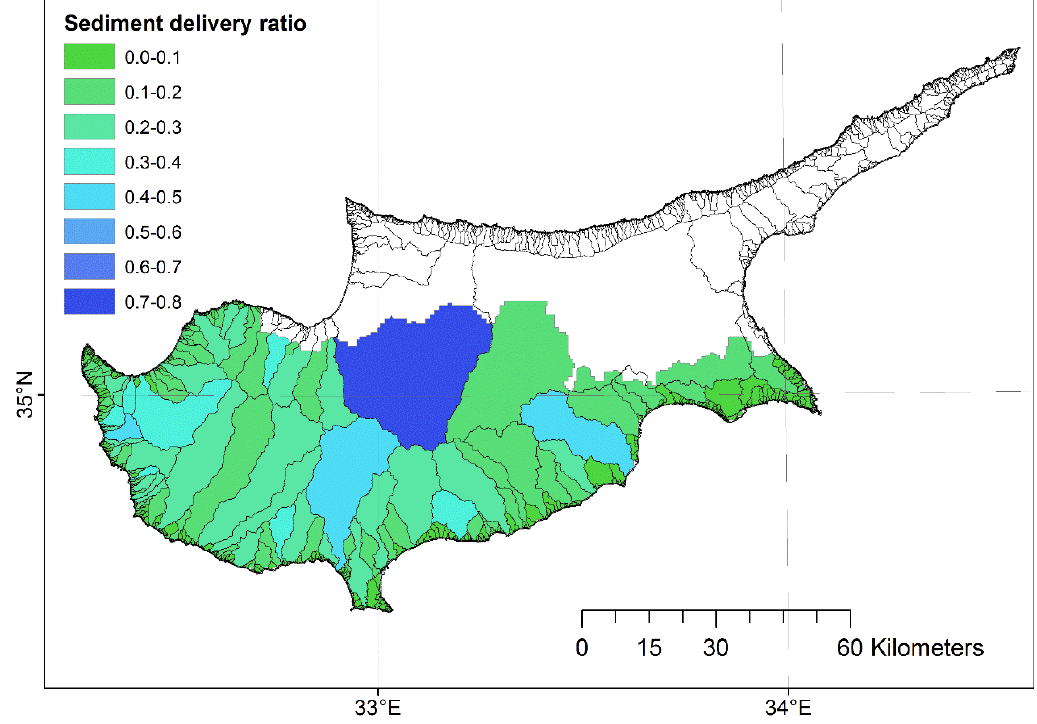
Figure 5. Choropleth map of the sediment delivery ratio (SDR) per river basin (value ranging: 0.1 step; mean value: